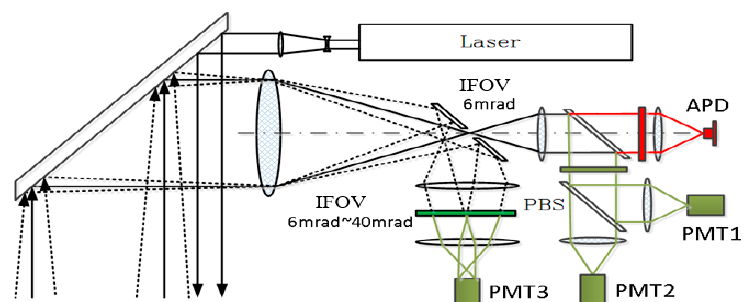
Figure A1. Schematic diagram of optical system in the Mapper5000 system [44]. IFOV: instantaneous field of view; APD: avalanche photodiode; PMT: photomultiplier tube; PBS: polarization beam splitter. The “Laser” contains a green laser and an NIR laser. The IFOV of the receiver is separated into two parts: a small center IFOV (6 mrad) and a large edge IFOV (6–40 mrad). The green light obtained from the small IFOV is split by a PBS and is received by PMT1 and PMT2.